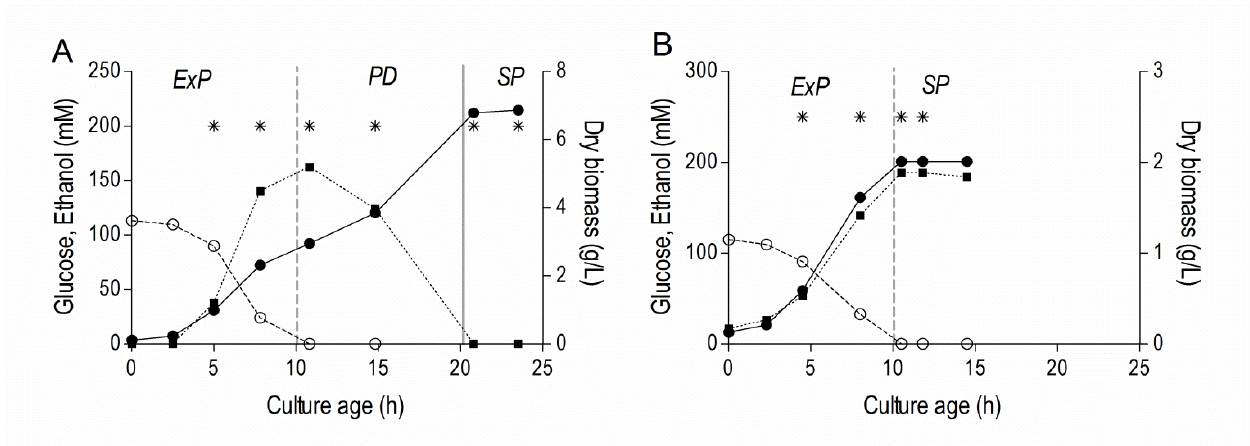
FIGURE 4: Growth phases in aerobic and anaerobic batch cultures. Biomass (closed circles, ●), glucose (open circles, ○) and ethanol (closed squares, ∎ ) concentration during the different growth phases of aerobic (A) and anaerobic (B) batch cultures of S. cerevisiae . The initial phase of exponential growth on glucose ( ExP ), the following post-diauxic phase of slower growth on non-fermentable carbon sources ( PD ) and final stationary phase ( SP ) are indicated. Values shown are from single representative batch cultures, independent replicate cultures yielded essentially the same results. Vertical lines indicate depletion of glucose (dashed line) and of fermentation products (solid line). Asterisks (*) indicate time points at which samples were taken for transcriptome analysis.